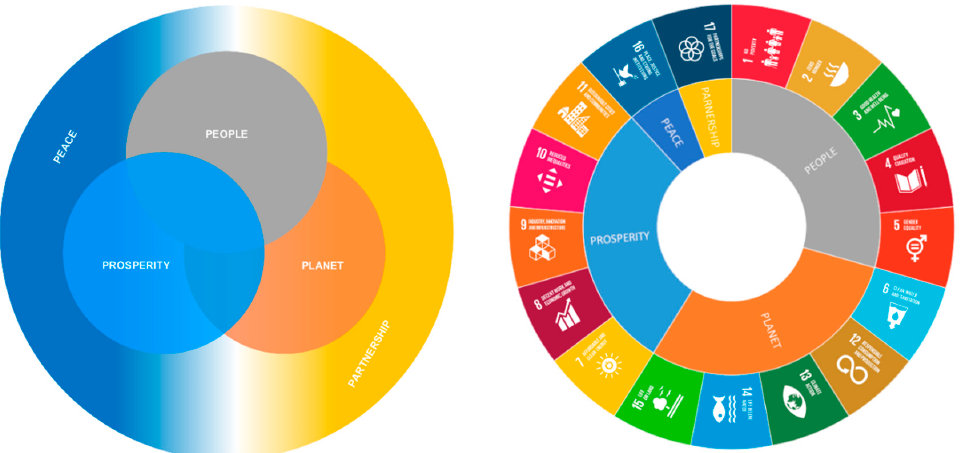
Figure 2. The 5Ps concept in the 2030 Agenda for Sustainable Development. The 5Ps concept includes People (Goals 1–5), Planet (Goals 6, 12–15), Prosperity (Goals 7–11), Peace (Goal 16), and Partnership (Goals 17).